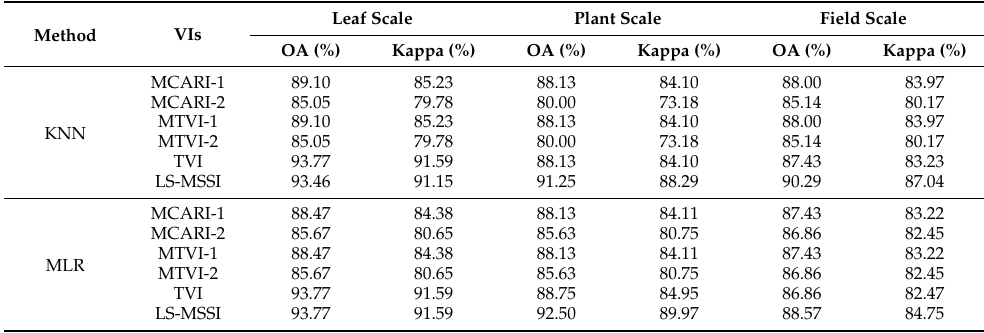
Table 8. Classification results of SIs at multiple scales.